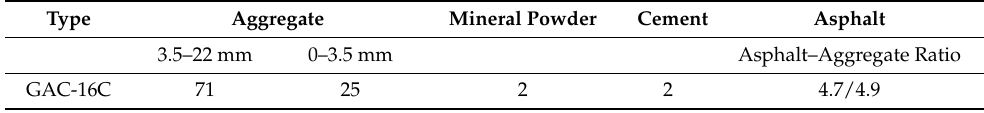
Table 2. Production mix ratio of ordinary asphalt concrete pavement.